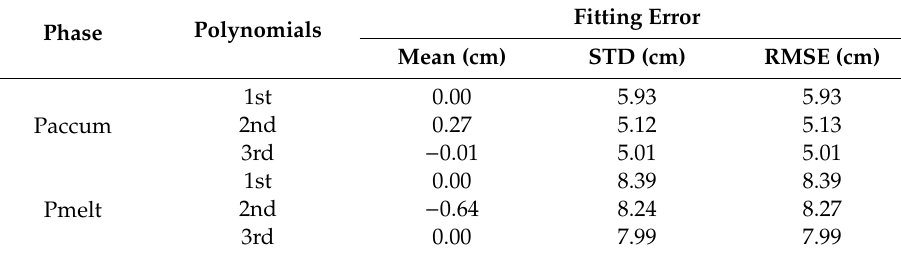
Table 3. Mean, STD and RMS of errors of fitting models for Paccum and Pmelt.